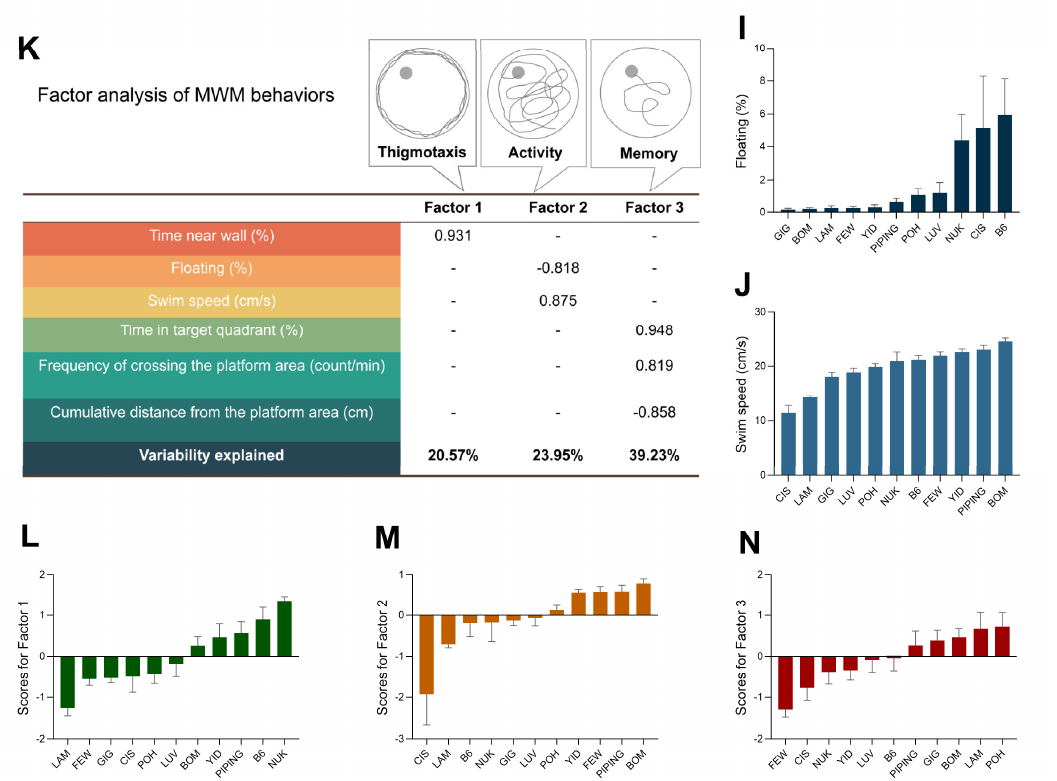
Figure 4. Phenotypic diversity in MWM task traits among the CC population. ( A ) Escape latency (s) to reach the platform on each day across the learning acquisition phase. ( B ) Thigmotaxis (%) to reach the platform on each day across the learning acquisition phase. ( C ) Mean escape latency (s) to reach the platform across the learning acquisition phase. ( D ) Mean Thigmotaxis (%) to reach the platform across the learning acquisition phase. ( E ) Thigmotaxis (%) in the target quadrant across the probe trial phase. ( F ) Time spent in the target quadrant across the probe trial phase (percent of total time, chance level = 25%). ( G ) Frequency of crossing platform area (count/min) across the probe trial phase. ( H ) Cumulative distance from the platform (m) to reach the platform across the probe trial phase. ( I ) Time spent floating (%) across the probe trial phase. ( J ) Average swim speed (m/s) across the probe trial phase. Plots are expressed as mean ± SEM, with CC lines ordered along the x -axis by mean per phenotype. ( K ) Factor analysis of behavioral variables during the probe trial phase of MWM task. Only factor loadings less than − 0.5 or greater than 0.5 which represent strong correlations are shown in the table, whereas factor loadings between − 0.5 and 0.5 are shown as hyphens. In the data set, factor analysis extracted three factors that together explain approximately 83.75% of the overall variance. Factor 1 (thigmotaxis), accounted for 20.57% of the variability, represents tendency to cling or follow the wall around the outer perimeter of the tank; factor 2 (activity), accounted for 23.95% of the variability, has strong negative factor loadings for floating and strong positive factor loadings for swim speed; factor 3 (memory), accounted for 39.23% of the variability, associated with more time in the target quadrant, less frequency of crossing the platform area, and less cumulative distance from the platform. ( L – N ) Mean factor score ( ± SEM) of each CC strain for the factors extracted from behavioral variables measured during the probe trial phase of MWM task. ( L ) Factor 1; ( M ) Factor 2; ( N ) Factor 3. Factor scores are displayed as deviation from zero in units of standard deviation, and the mean factor score of all 94 subjects are zero. (( A ) Two-way repeated measures ANOVA test detected a strain x day interaction effect ( p < 0.001), an effect of strain ( p < 0.001) and an effect of day ( p < 0.001) on the latency to find the platform during acquisition training. ( B ) Two-way repeated measures ANOVA test detected a strain × day interaction effect ( p < 0.001), an effect of strain ( p < 0.001) and an effect of day ( p < 0.001) on the thigmotaxis during acquisition training. ( C – J ) one-way ANOVA p < 0.001. ( L – N ) one-way ANOVA p <